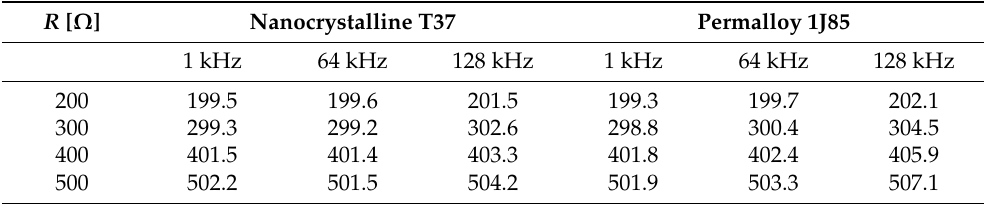
Table 3. Impedance values of different sensors under different